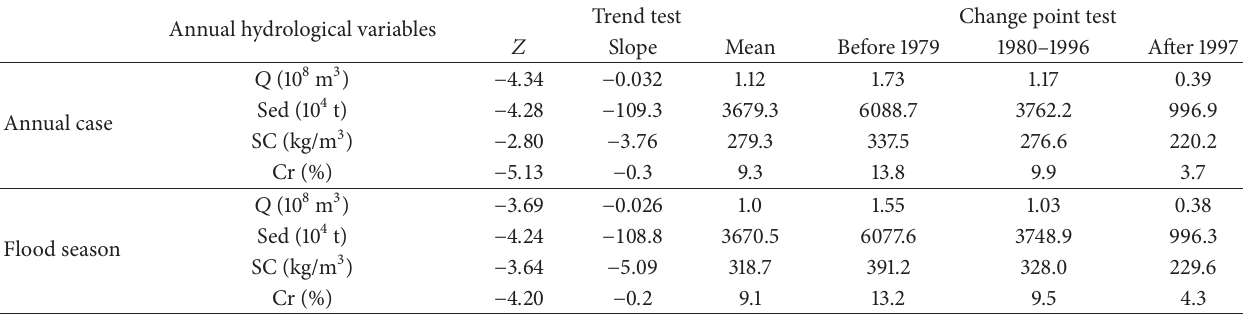
Table 1: Statistics of streamflow and sediment load at the annual and flood season scales during 1965–2010.